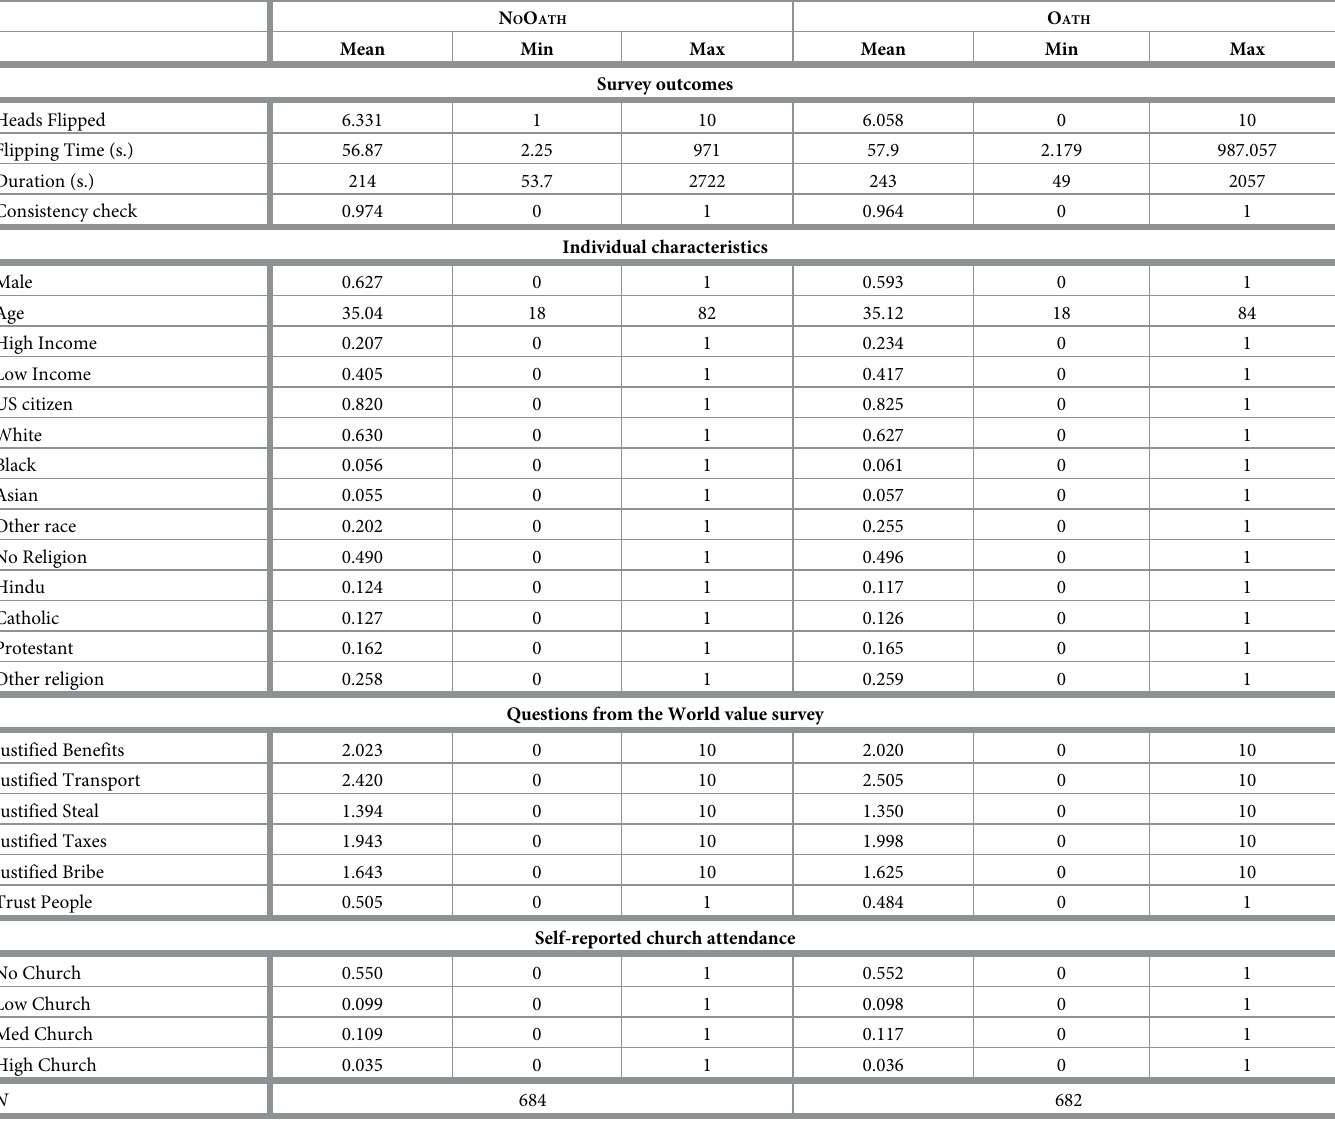
Table 1. Summary